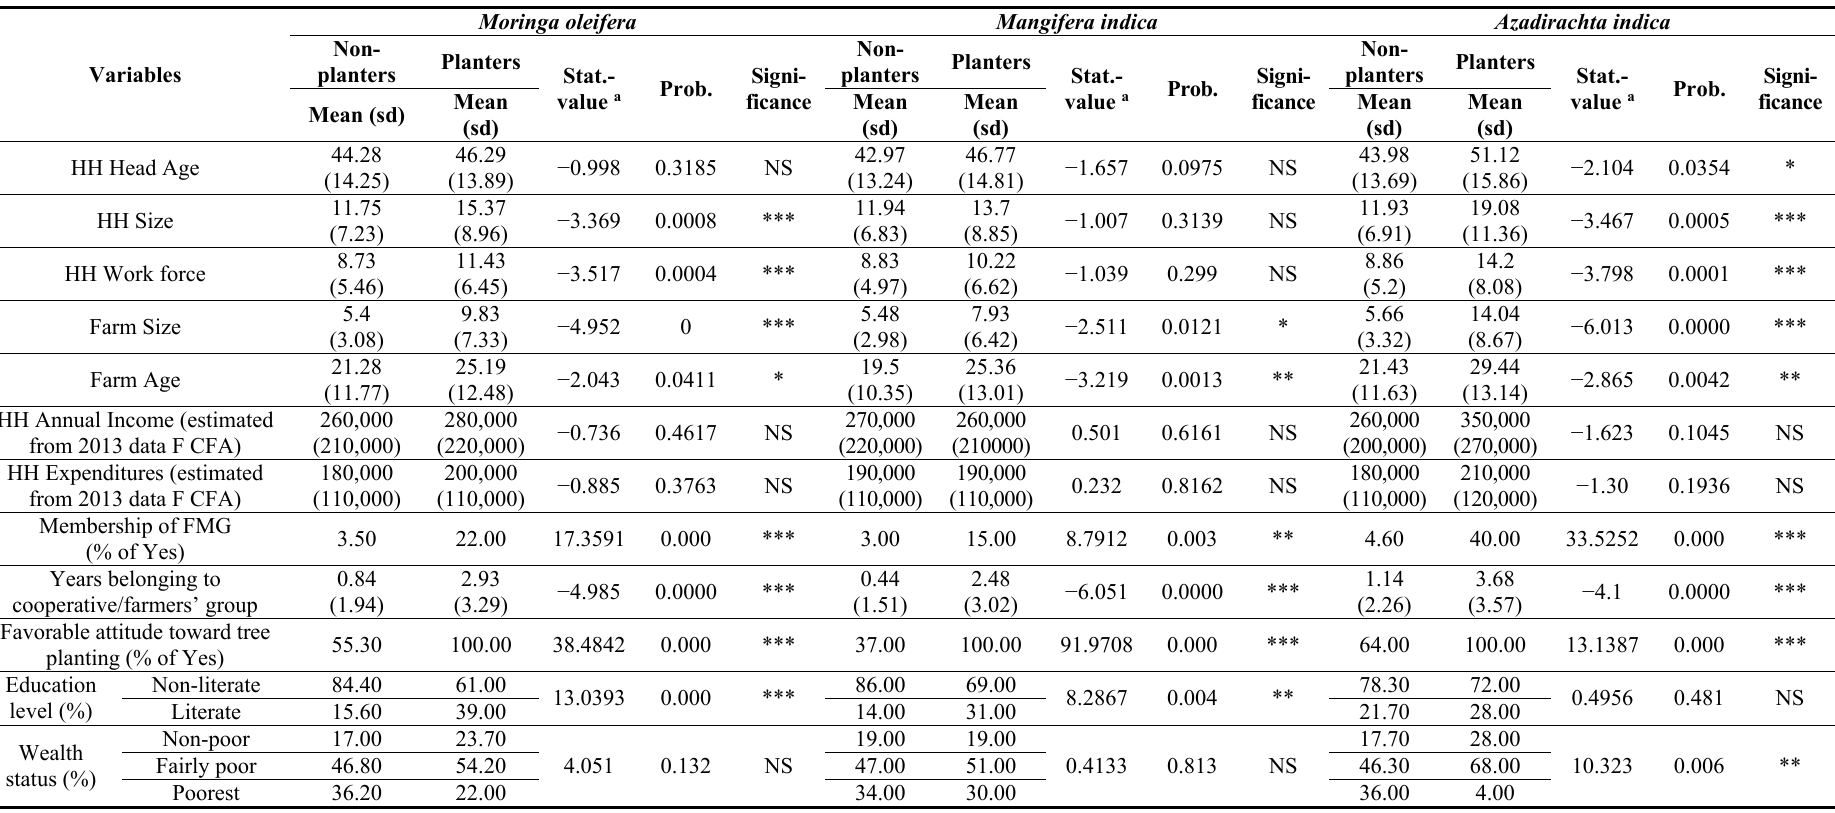
Table 3. Socio-economic and perceptional characteristics between Moringa oleifera planters ( n = 59) and non-planters ( n = 141), Mangifera indica planters ( n = 100) and non-planters ( n = 100), and Azadirachta indica planters ( n = 25) and non-planters ( n =